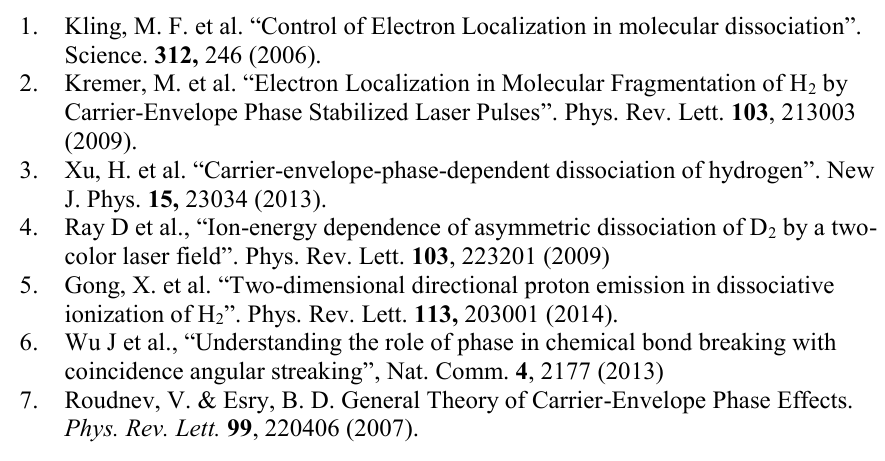
Fig. 2 Asymmetry in proton emission as a function of the electron emission angle 𝜙 𝑚𝑜𝑙𝑒 and CEP for proton energies